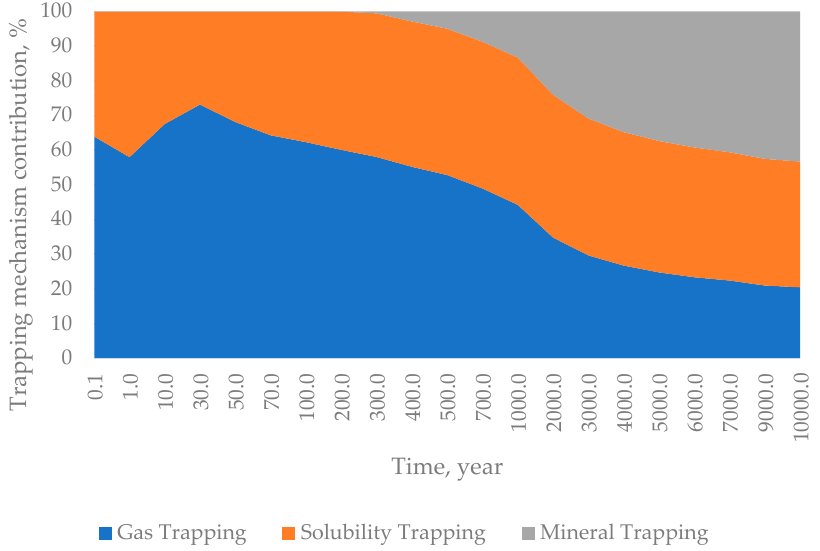
Figure 9. Graph showing contribution of different trapping mechanisms for base case through time. For the homogeneous case, solubility trapping begins at ~45% and decreases to 35% at ~1 year. (Figure 10). After that, it decreases to ~30% at 10 years and increases gradually during post-injection until the end of the simulation, where it reaches 47%. Mineral trapping does not occur until ~500 years. Its percentage gradually increases to ~25% at 10,000 years. More than half of the injected CO 2 is in gas form until ~1000 years. After that, gas trapping gradually decreases to ~28% at the end of the simulation.